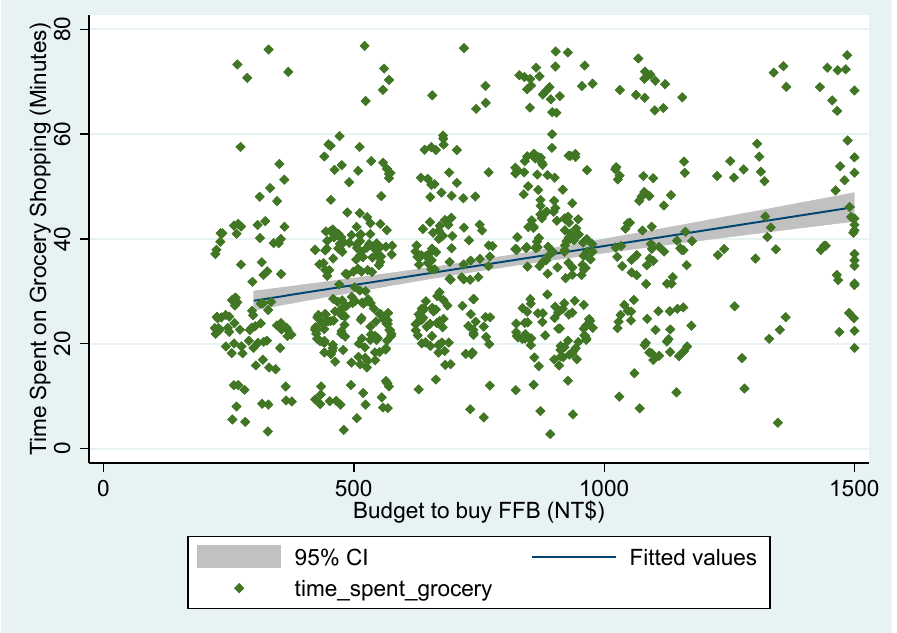
Figure 3. The relationship between time spent on grocery shopping and fresh food box budget. Note: FFB means a fresh food box.